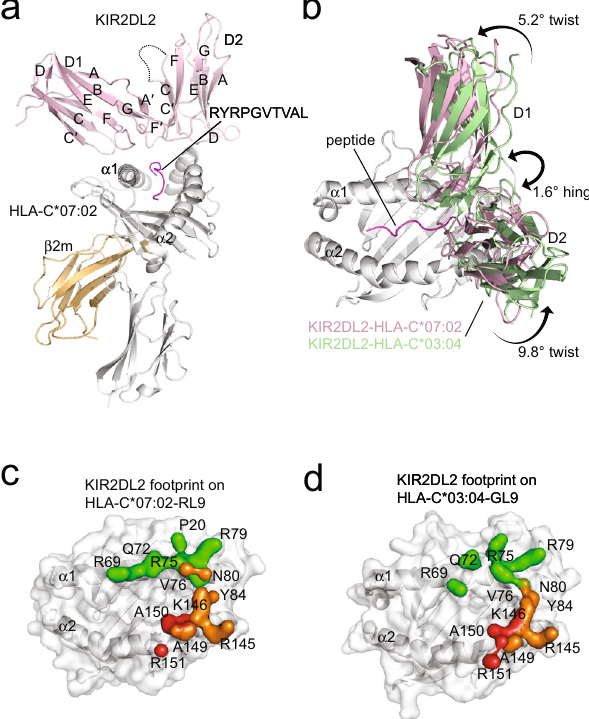
Fig. 1 Structural comparison of KIR2DL2 in complex with HLA-C*07:02- RL9 and HLA-C*03:04-GL9. a Overall structure of KIR2DL2 in complex with HLA-C*07:02-RL9. The complex is represented in cartoon format with KIR2DL2 coloured pink, HLA-C*07:02 coloured grey, β 2 m coloured orange and the peptide coloured magenta. b Comparison of KIR2DL2 in complex with HLA-C*03:04-GL9 (KIR coloured green) and HLA-C*07:02-RL9 (KIR coloured pink). The relative difference in hinge and twist angles of the KIR is shown. Footprints of KIR2DL2 on HLA-C*07:02-RL9 ( c ) and HLA-C*03:04- GL9 ( d ) coloured by domain binding. D1 contacts coloured green, D1-D2 interdomain loop contacts coloured red and D2 contacts coloured